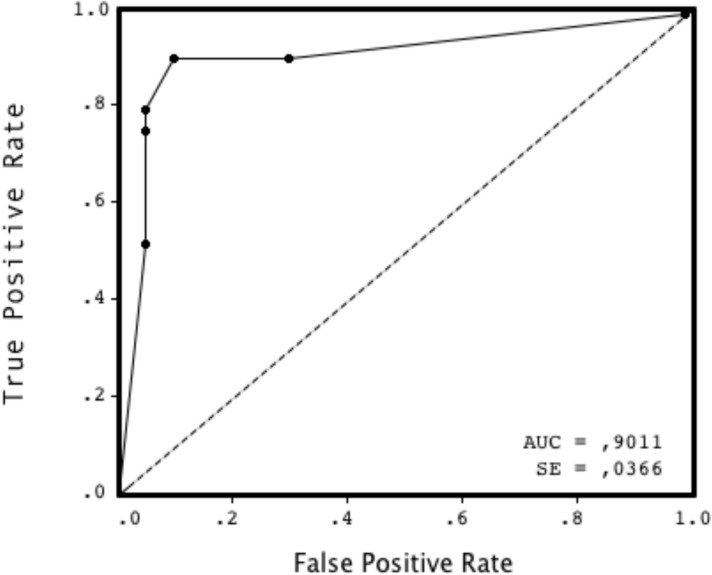
Receiver operating characteristic (ROC) curve for the signal-to-cutoff (S/CO) ratio of the Monolisa HCV Ag-Ab ULTRA ELISA assay (Bio-Rad) for the prediction of active (positive HCV RNA) hepatitis C infections.The area under the ROC curve (AUC) was 0.90.